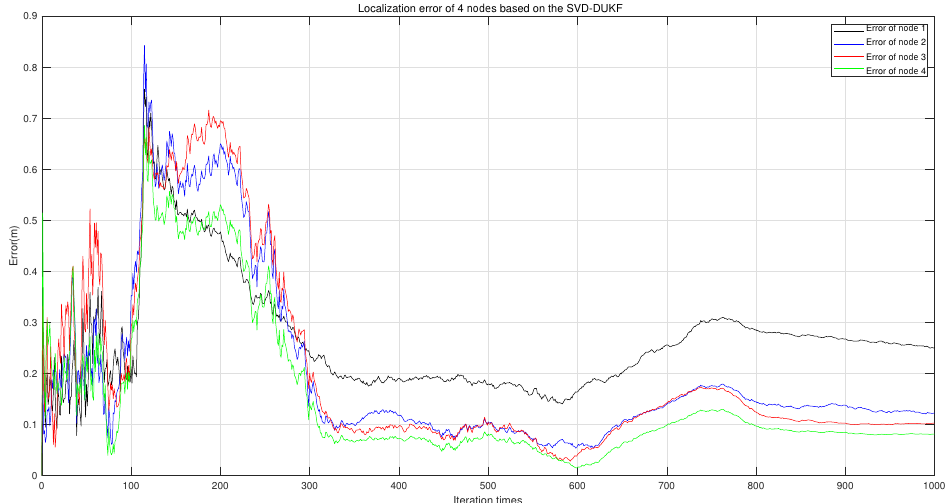
Figure 5. One Monte Carlo trial of the UKF-based 3D RO-localization algorithm.